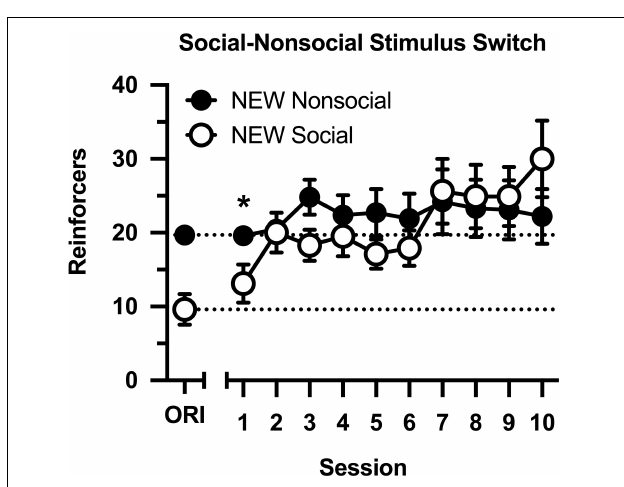
FIGURE 4 | Number of reinforcers obtained during daily, 60-min test sessions. Data reflect the mean (SEM) number of cocaine infusions from rats newly switched to the non-social (filled symbols; n = 10) and social (open symbols; n = 8) groups. During all sessions, responding was maintained by cocaine (0.5 mg/kg) and 30-s access to either a social (sex- and age-matched partner) or non-social (black-and-white athletic sock) stimulus. Dashed lines originating at the X-intercept reflect the average number of cocaine infusions during Session 10 of the groups’ original assignments (ORI). Asterisk indicates significant difference between social and non-social